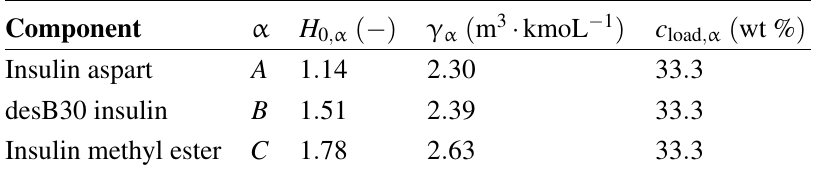
Table 2. Kinetic parameters of the Langmuir self-association adsorption model Equation (2). The feed composition, c , is given in fractional weights for each insulin component and load , α the total feed concentration is 2 . 0 10 1 ( moL m − 3 ) × ·